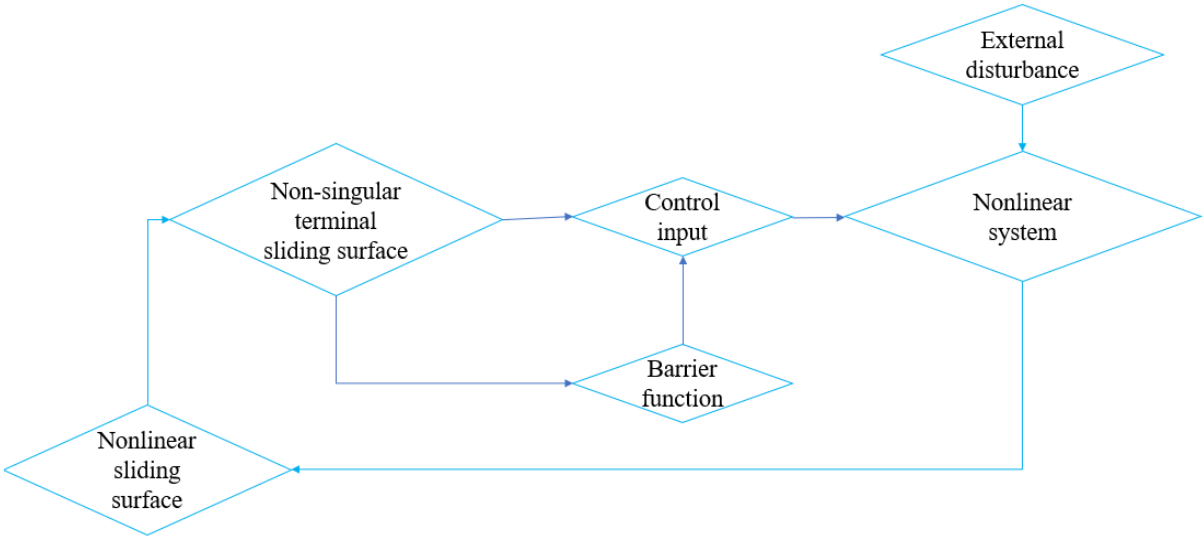
Figure 1. Block diagram of the above-designed technique.